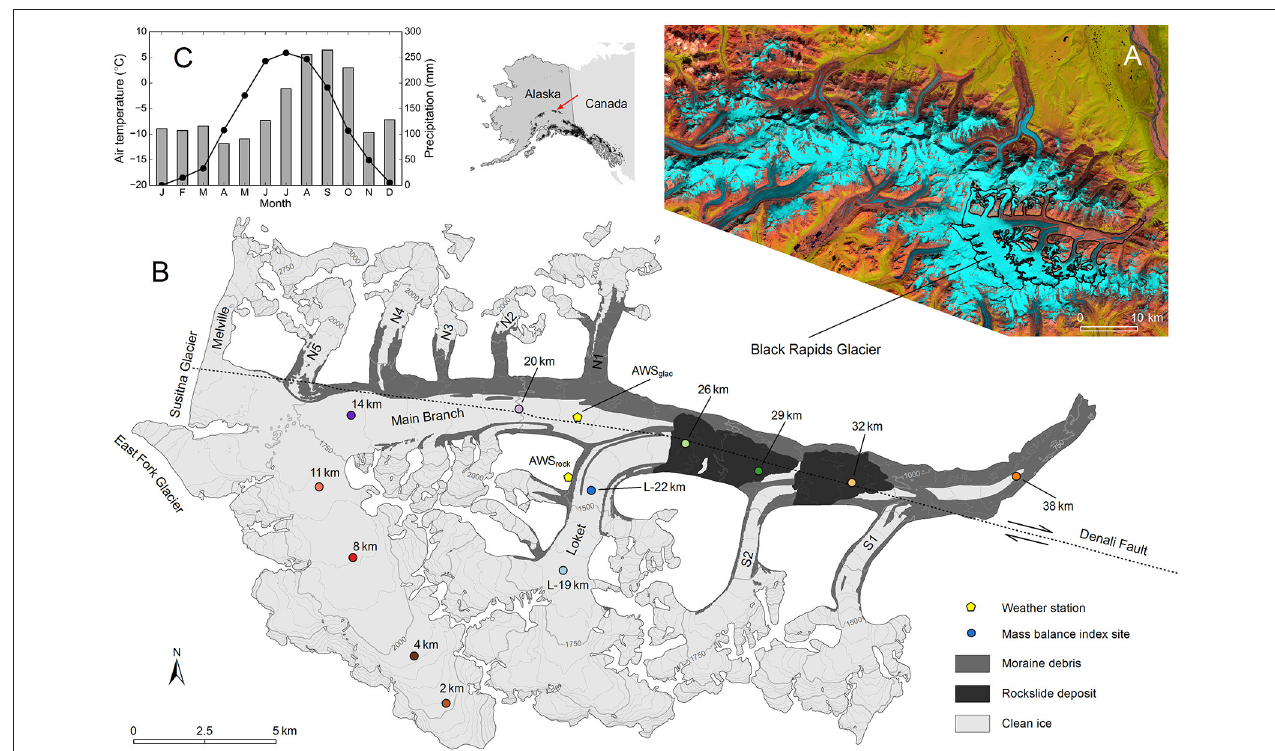
FIGURE 1 | (A) Landsat Operational Land Imager (OLI) false color composite from July 13, 2013, showing Black Rapids Glacier along with the glaciers of the Hayes Range (western part of the Eastern Alaska Range). (B) Map of Black Rapids Glacier with glacier extent, surface topography, debris cover and rockslide deposits for the year 2010. The approximate location of the Denali Fault, the locations of the mass balance index sites and the automatic weather stations (years 2012–2014) are also shown. (C) Monthly mean temperatures (dotted line) and total precipitation (bars) based on the Parameter-elevation Relationships on Independent Slopes Model (PRISM) climatology ( Daly et al., 1994). The diagram was derived by averaging temperature and precipitation from all the PRISM grid points within Black Rapids’ perimeter (62